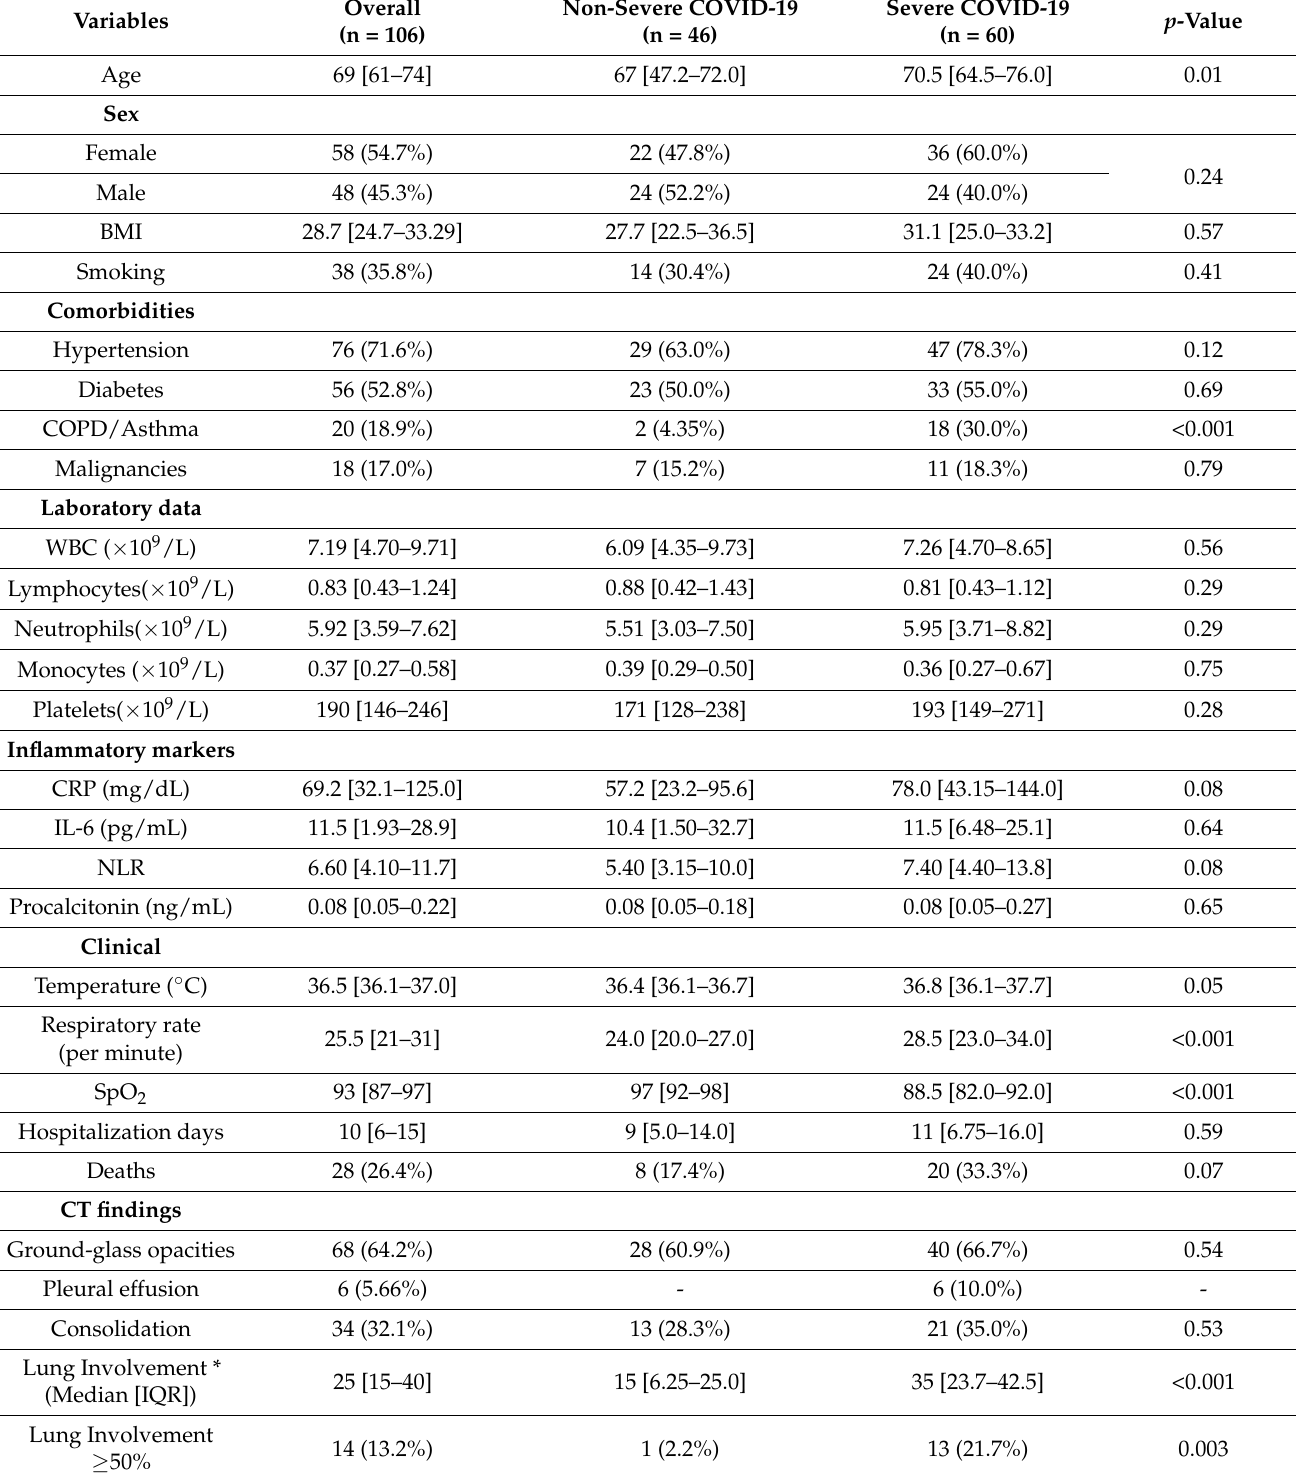
Table 1. Baseline characteristics of patients (n =